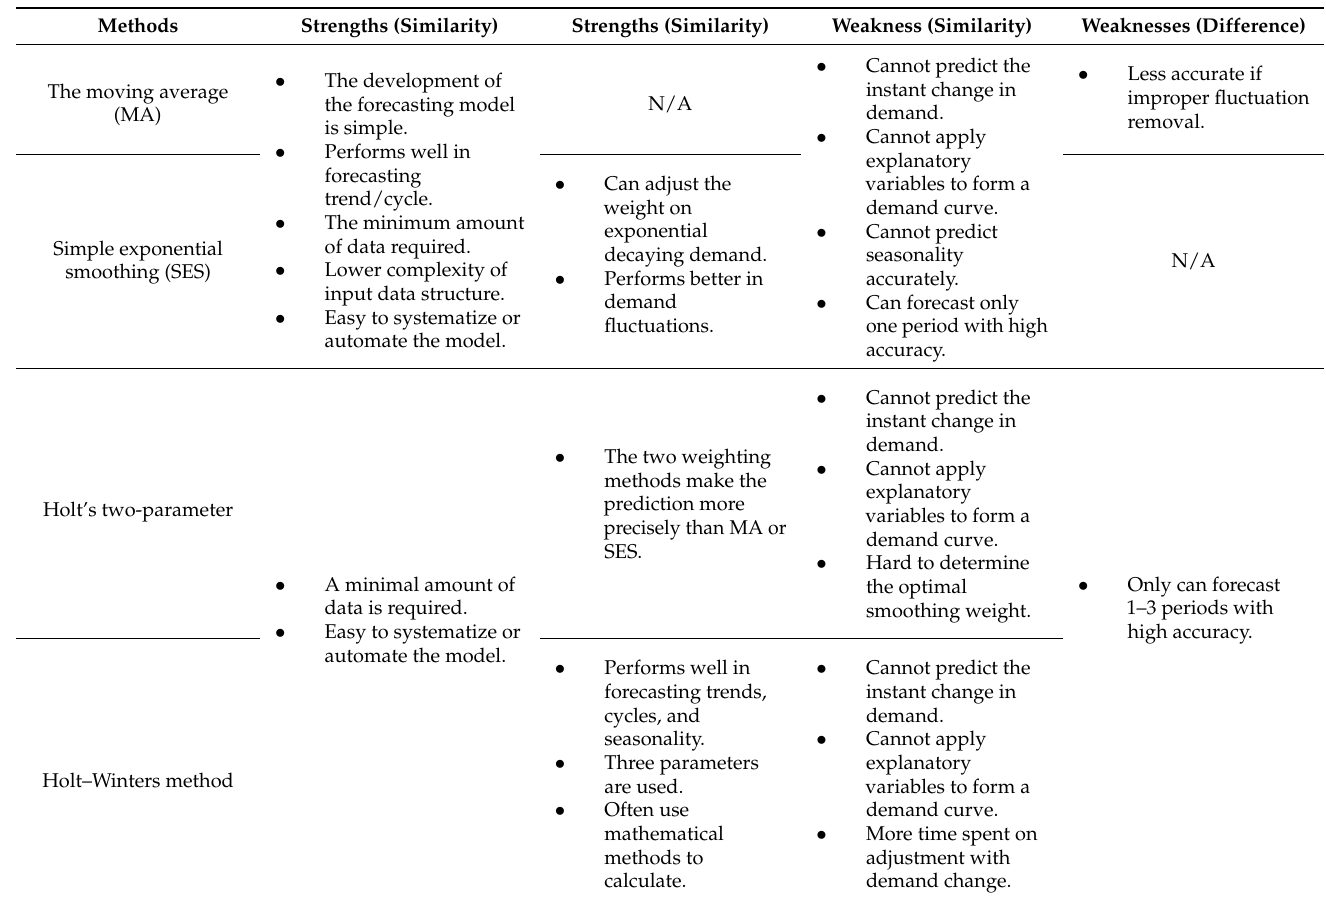
Table 1. Summary of four time–series